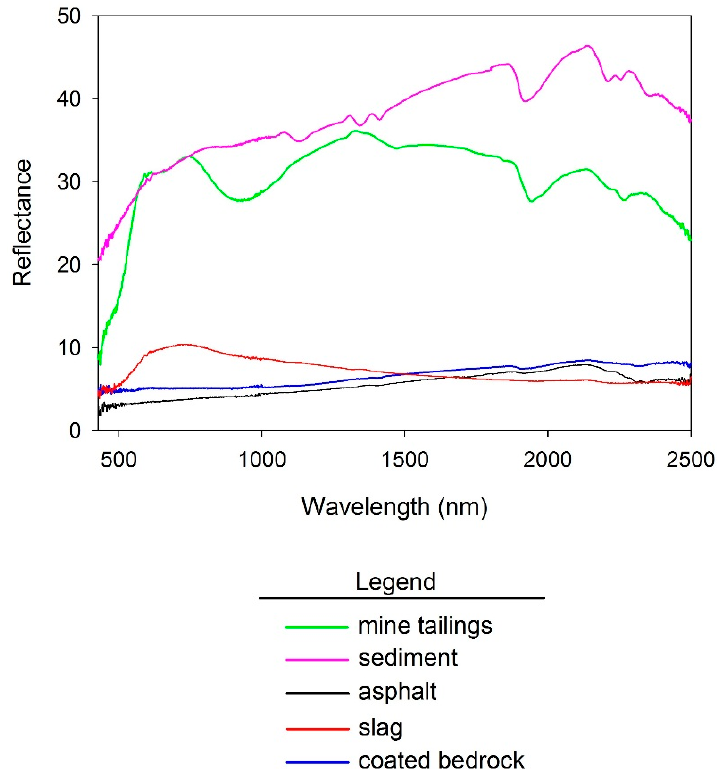
Figure 5. Comparison between lab-measured spectra obtained for tailings, sediment, asphalt, slag, and coated bedrock in the Sudbury region. The tailings spectrum is derived from a sample of materials associated with the main smelter in the Copper Cliff study area, the sediment spectrum is derived from a sample of materials exposed at the sediment pit marked “SP” in Figure 6c, the asphalt spectrum is derived from a sample of materials typical of paved roadways in the Sudbury region, the slag spectrum is derived from a sample collected at a Coniston slag heap, and the coated bedrock spectrum is derived from a coated sample of the Copper Cliff Formation. The above spectra are expressed as percentages and were measured at centimeter scale over wavelengths of 400 to 2500 nm using a FieldSpec3 spectrometer equipped with a contact probe and integrated illumination source.